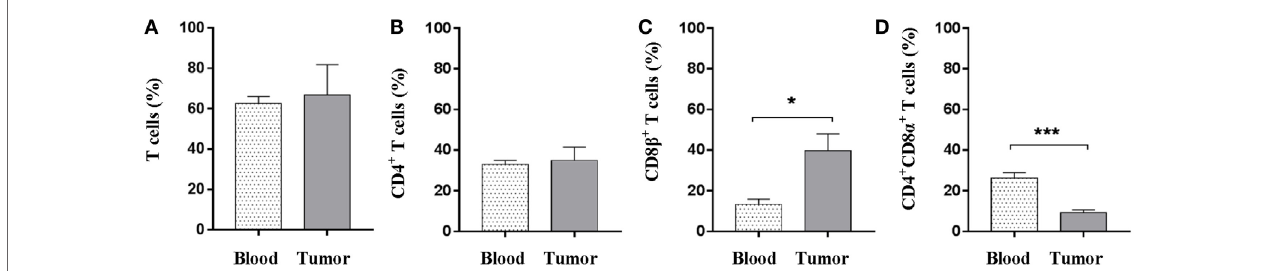
FigUre 2 | CD8 β + T cells specifically infiltrate the established tumors. Oncopigs were subcutaneously injected with AdCre. PBMCs and tumor tissue were harvested 7–21 days post injection and analyzed using flow cytometry. Cells were pre-gated on viable, single lymphocytes. (a) Numbers represent CD3 + cells as a percentage of live cells. (B) Percentage of CD4 + cells in live, CD3 + -gated cells. (c) Percentage of CD8 β + cells in live, CD3 + -gated cells. (D) Percentage of CD8 α + cells in live, CD3 + CD4 + -gated cells. Bars represent mean values ± SEM, and data are from two independent experiments ( n = 4–5), where n indicates the number of animals. Statistical evaluations were performed by unpaired Student’s t -test (* P < 0.05 and *** P <